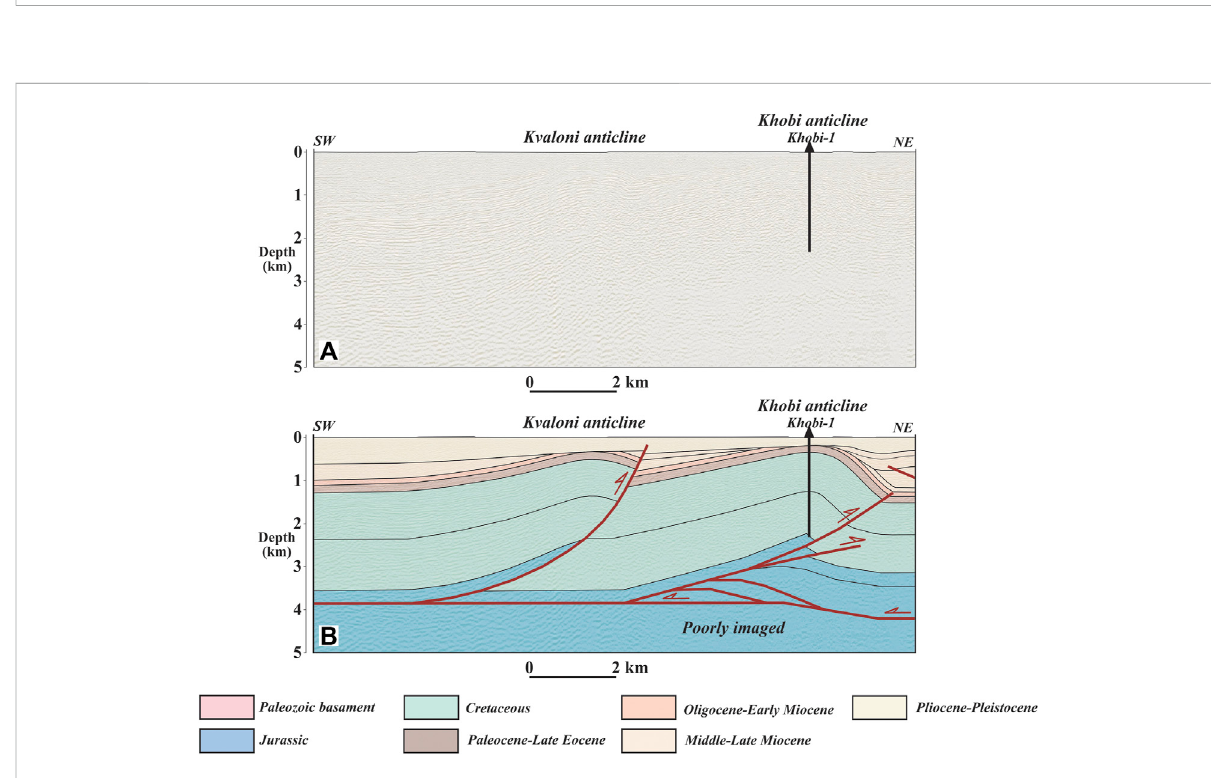
construction of the regional balanced and restored cross- sections (A-A I ) across RFFTB (Figures 6A,B). The balanced cross-section is approximately parallel to the thrust transport direction and has a total length of 64 km. Interpretation of 2D